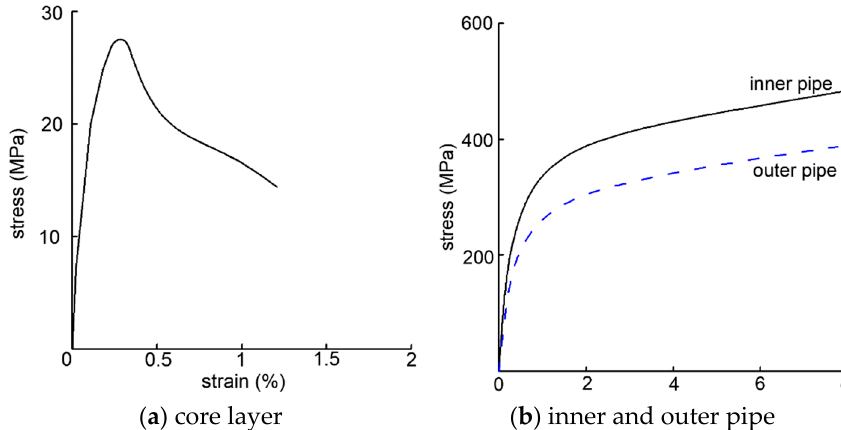
Figure 1. Strain–stress relationship of SPs materials in the experiment by An et al. [6].